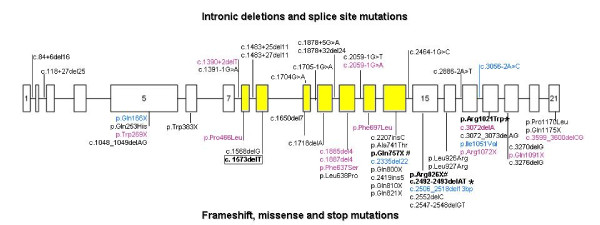
Map of known mutations in the RECQL4 gene (exons are indicated by boxes and introns by interconnecting lines) in RTS (black), RAPADILINO (purple) and BGS (blue) patients. Yellow identifies the exons encoding the helicase domain. Intronic deletions and splice site mutations are grouped above, while frameshift, missense and stop mutations are grouped below the graphic representation of the gene. Bold characters indicate mutations shared by RTS and RAPADILINO (#), RTS and BGS (*) and by RTS, RAPADILINO and BGS (framed).